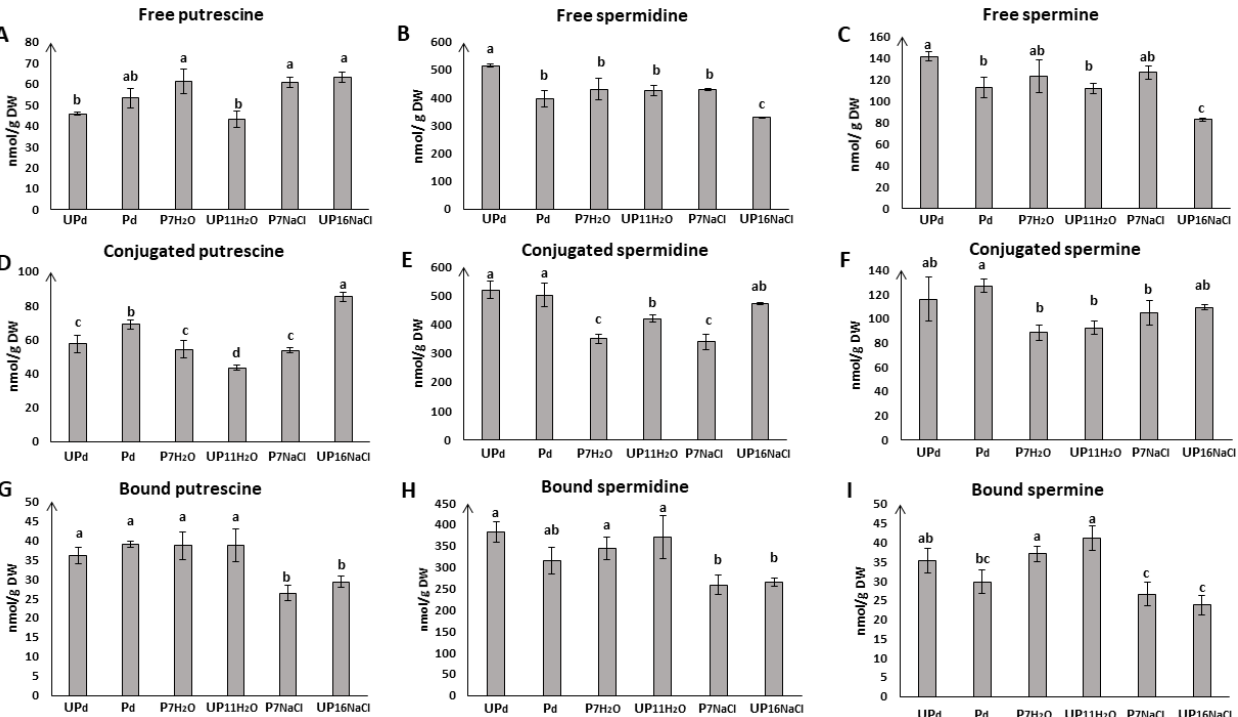
Figure 2. Concentration of ( A ) free putrescine, ( B ) free spermidine, ( C ) free spermine, ( D ) conjugated putrescine, ( E ) conjugated spermidine, ( F ) conjugated spermine, ( G ) bound putrescine, ( H ) bound spermidine, ( I ) bound spermine in the seeds of Brassica napus before the start of germination (dry unprimed seeds, UP d and primed dried seeds, P d ) as well as during germination (primed seeds germinating for 7 h in water, P 7H 2 O ; unprimed seeds germinating for 11 h in water, UP 11H 2 O ; primed seeds germinating for 7 h in NaCl, P 7NaCl ; u nprimed seeds germinating for 16 h in NaCl, UP 16NaCl ). The differences were statistically significant, as determined by one -way analysis of variance (ANOVA) and Tukey –Kramer multiple comparison test ( n = 6, p < 0.05). The vertical bars denote SD. The same letters on bars describe not significant differences between means.